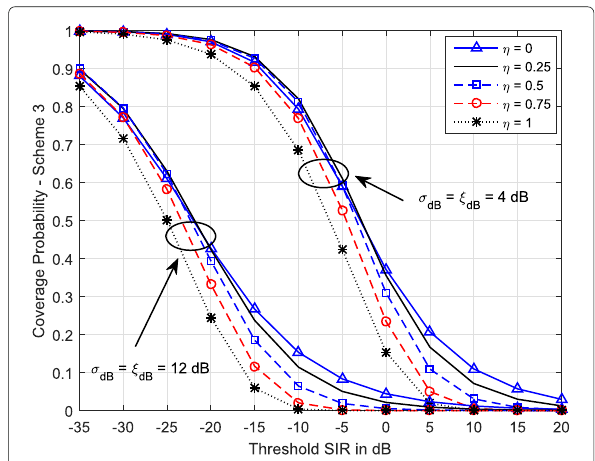
Fig. 6 Coverage probability of Scheme 3 vs SIR threshold for different η values. λ = 0.5 BSs/km 2 , α = 3.5, ρ = − 30